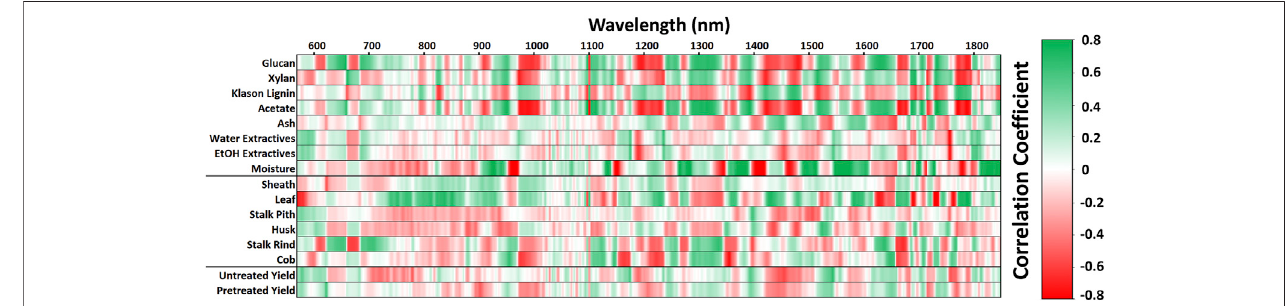
FIGURE 4 | Second derivative of NIR absorbance spectra for anatomically pure fractions of corn stover in the region from (A) 850 – 1,050 nm, (B) 1,075 nm – 1,125 nm, and (C) 1,500 nm – 1775 nm.